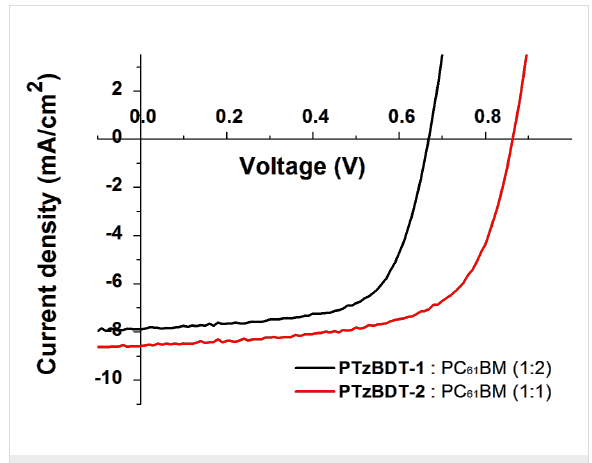
Figure 3: J – V plots, measured under standard illumination (AM1.5G, 100 mW/cm 2 ), of PTzBDT-1: PC 61 BM and PTzBDT-2: PC 61 BM BHJ based